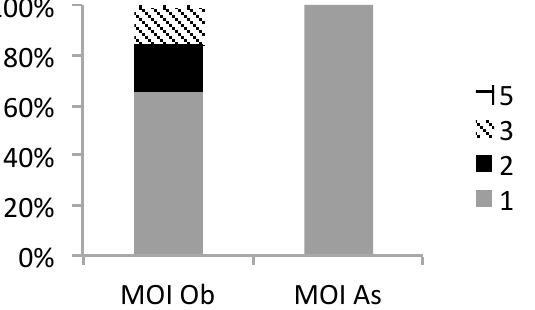
Figure 1. Multiplicity of P. falciparum infection determined by Msp2. A graphical representation of the total number of fragments (gray ( 1 ), black ( 2 ), diagonal stripes ( 3 ) and checkered ( 5 )) detected in each sample expressed as a % of the number of samples positive for Msp2 at Obom (Ob) and Asutsuare (As).